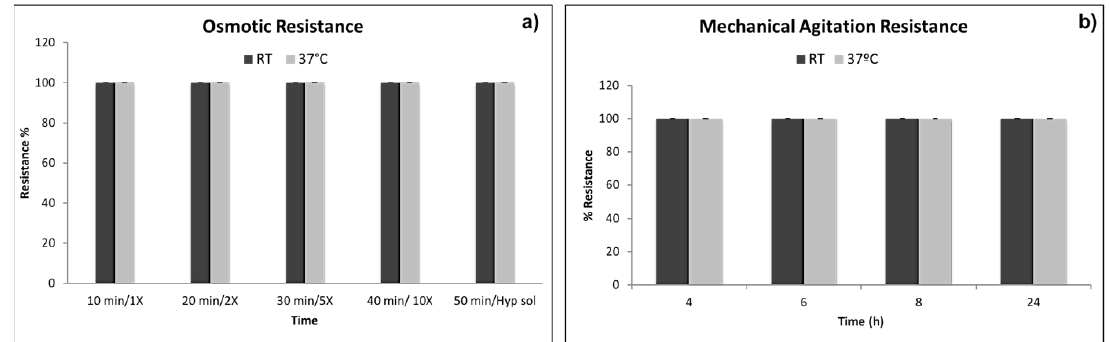
Figure 5. Mechanical stability tests. (a) % of microcapsules osmotic resistance at increasing medium osmolarity concentration; (b) % of microcapsules resistance upon mechanical agitation.